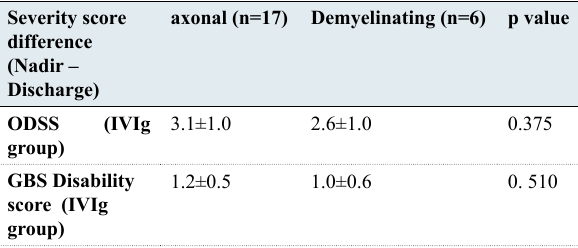
Table 5: Clinical Severity according to ODSS and GBS